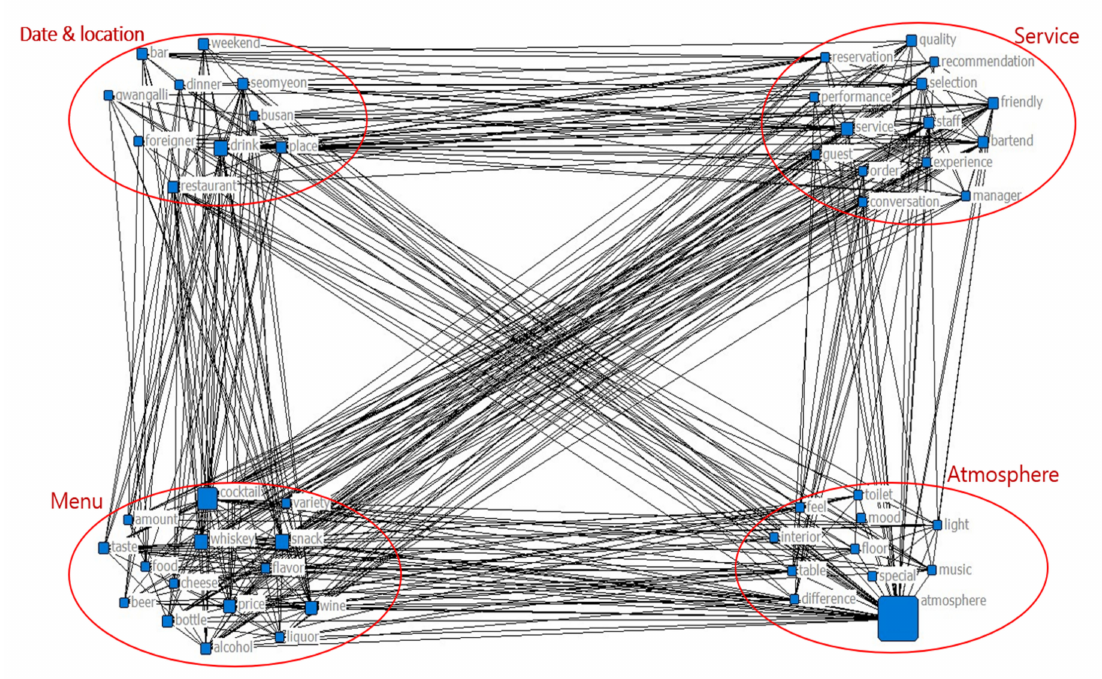
Figure 5. Visualization with CONCOR